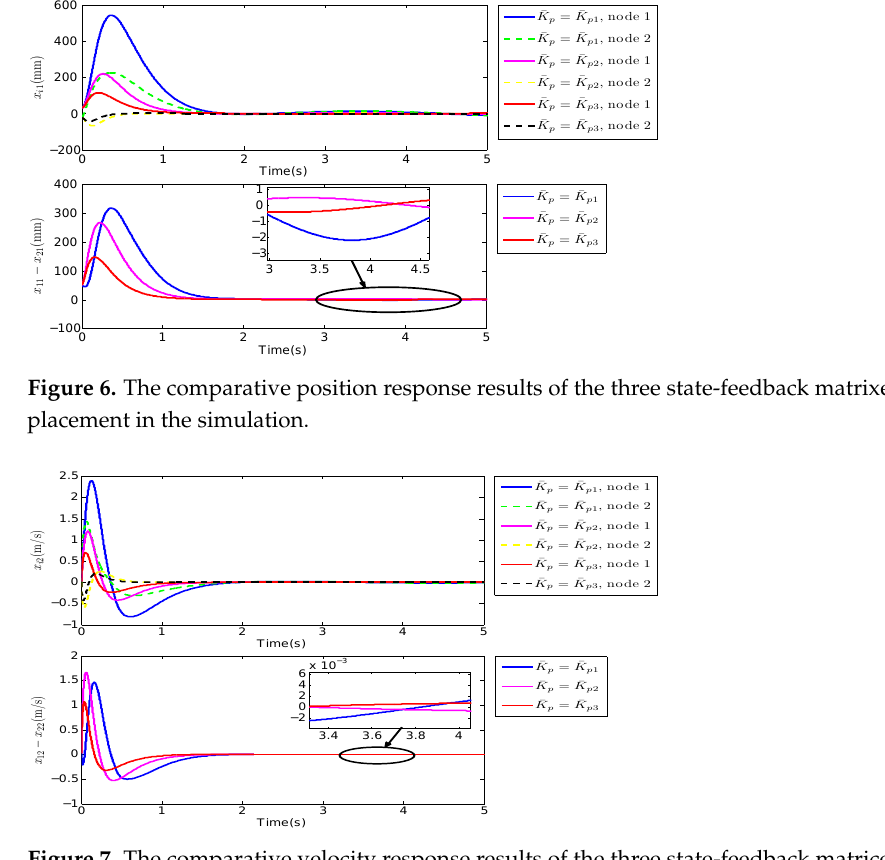
Figure 7. The comparative velocity response results of the three state-feedback matrices using pole placement in the simulation.